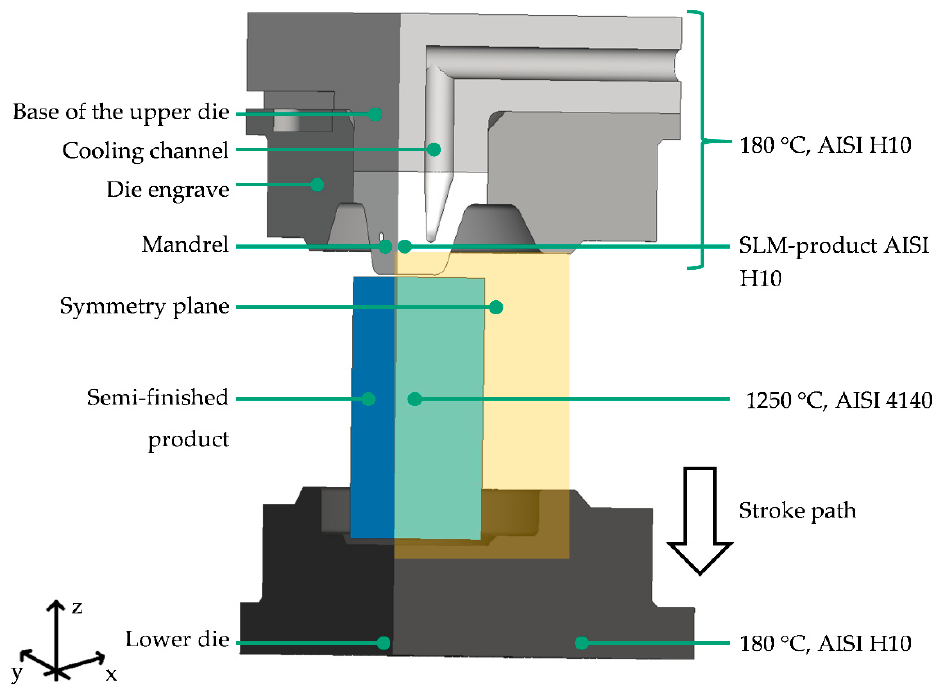
Figure 4. Sectional view of the designed model for the simulation of Variant 06 with start temperature (for the semi-finished product before transfer to the press) and material classification (F = circular, Ø = 1.50 mm, S = 5.00 mm and R = 5.75 mm).